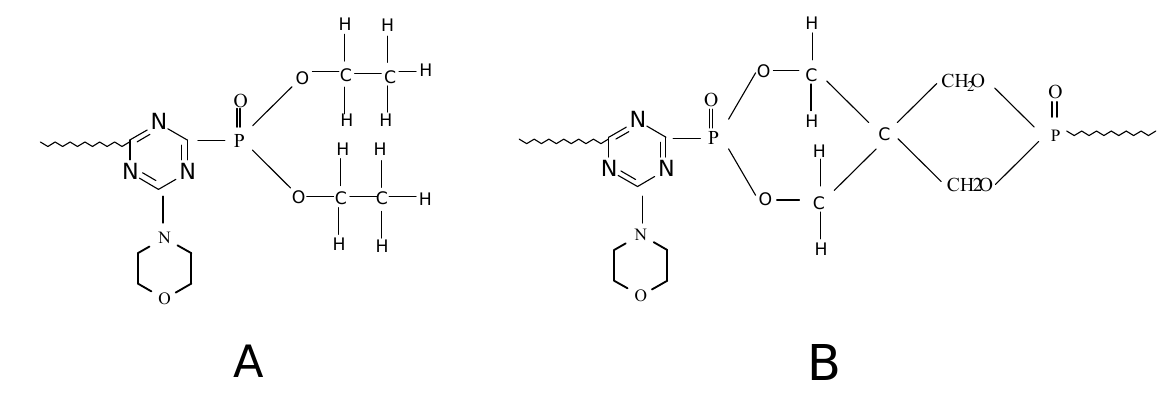
Figure 6. Phosphorus atoms in two different chemical environments.